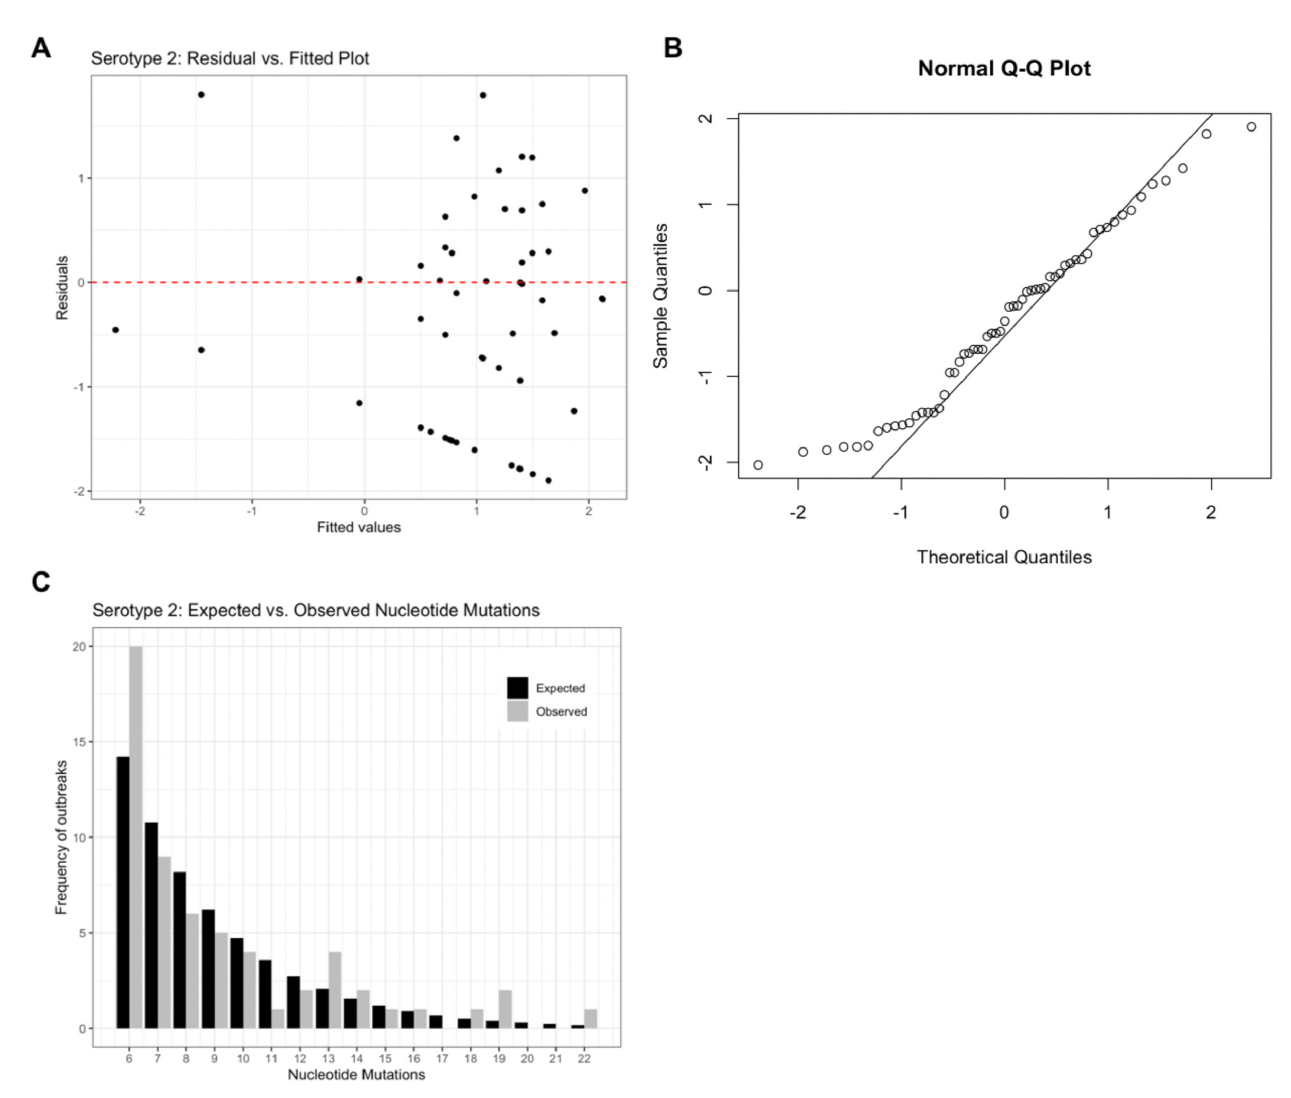
Figure 2. Serotype 2 diagnostic plots. ( A ) residual vs. fitted values, ( B ) Normal Q-Q plot and ( C ) Expected vs. observed frequencies of nucleotide mutations assuming a negative binomial distribution. Figure 2A shows how far the fitted values vary from the residual values, the closer to the red dashed line, the better fit. Figure 2B is used to analyse the distribution of the data. Because several points at the bottom left of the figure deviate from the Q-Q line, the data is positively skewed towards lower nucleotide